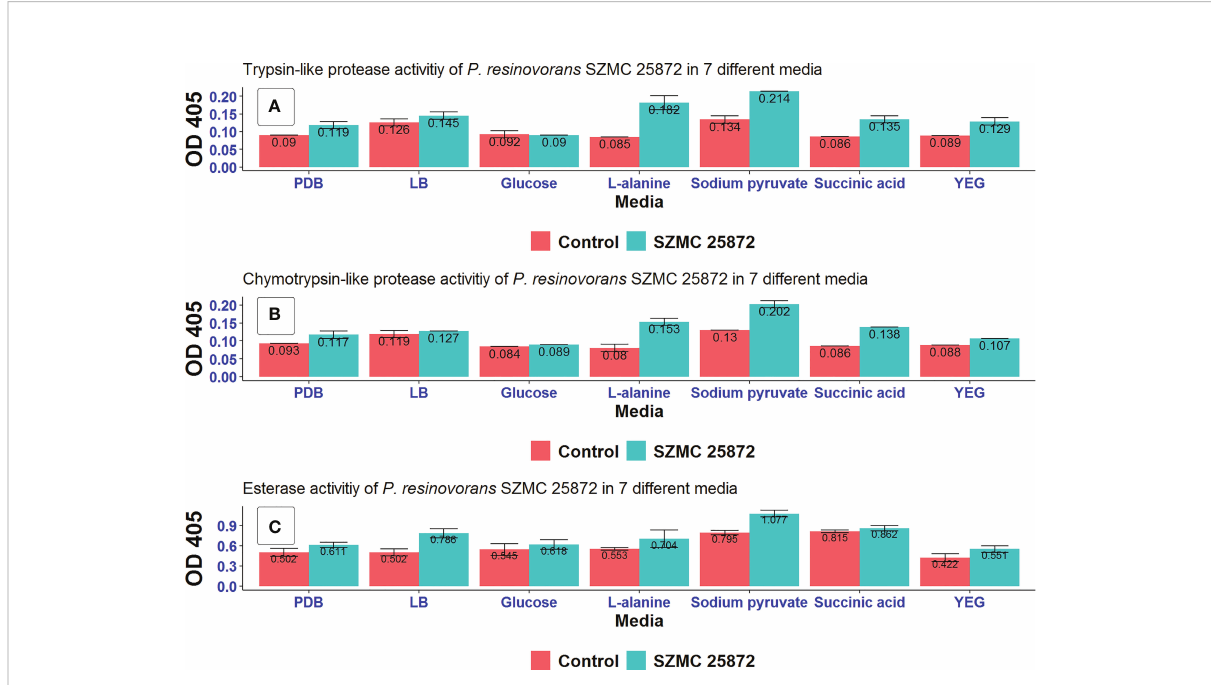
FIGURE 6 Extracellular enzyme activities (A) trypsin-like proteases, (B) chymotrypsin-like proteases, and (C) esterases of P. resinovorans SZMC 25872 grown in different media. Control is negative control (non-inoculated